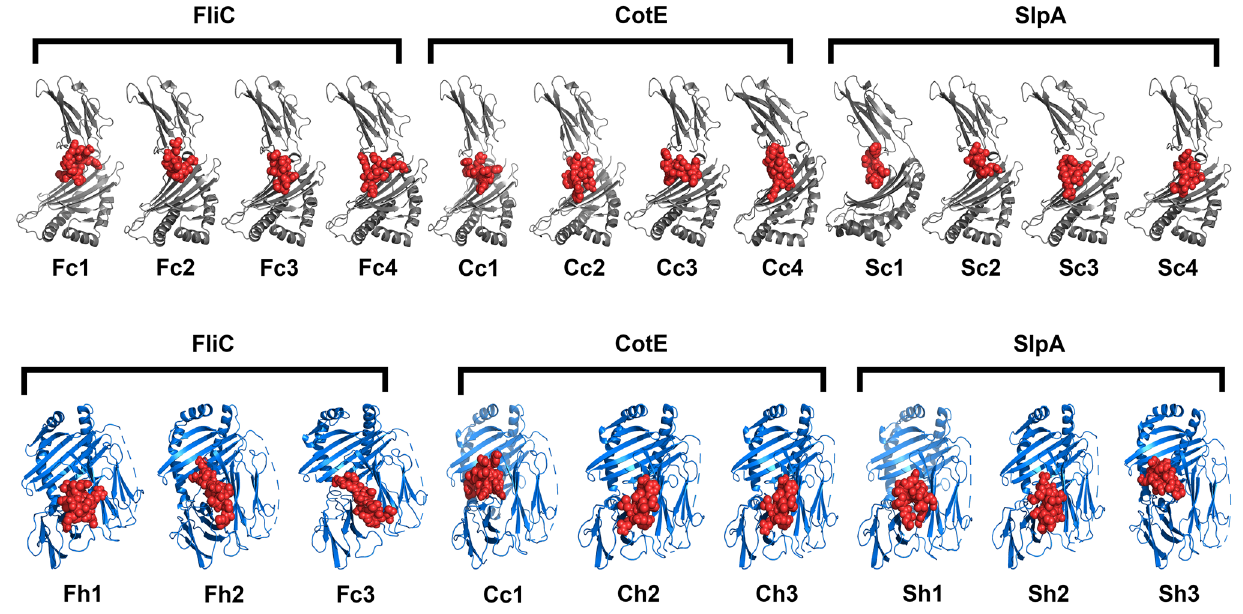
Figure 4. Docking of individual epitopes with MHC class I and class II receptors. ‘c’ represents the CTL epitopes docked with MHC class I receptor (grey colour) and ‘h’ represents the HTL epitopes docked with MHC class II receptor (blue colour). All the epitopes are depicted in red colour spheres. ‘F’ denotes epitopes derived from FliC protein, ‘C’ denotes epitopes from CotE protein and ‘S’ denotes the epitopes from SlpA protein. The arrangement of the epitopes are based on their position in the vaccine construct.